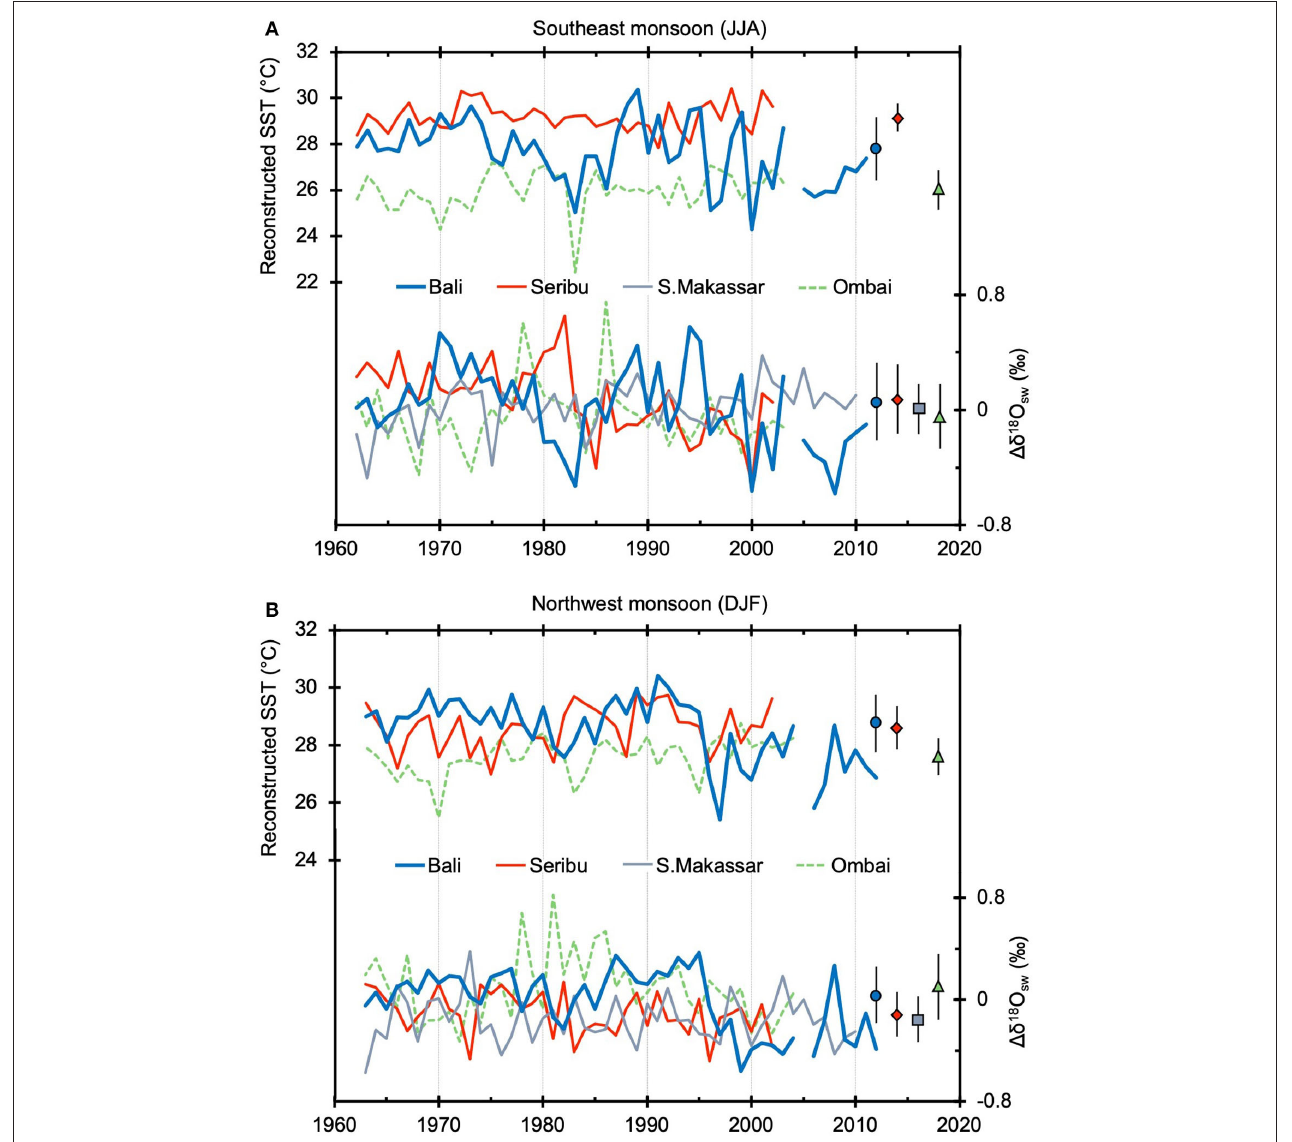
FIGURE 9 | Time series of SST and 1 δ 18 O sw reconstructed from coral Sr/Ca and δ 18 O in Bali (blue, in this study), Seribu (red, Genda et al., 2022), southern Makassar Strait (gray, Murty et al., 2017), and Ombai Strait (green, Cahyarini et al., 2014) records for (A) the southeast monsoon (JJA) and (B) the northwest monsoon (DJF). The mean value with error bar ( ± 1SD) at each site is represented at right side in the